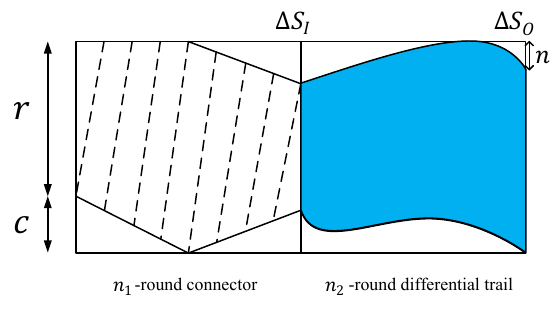
Figure 2: Overview of Guo et al. ’s ( n 1 + n 2 )-round collision